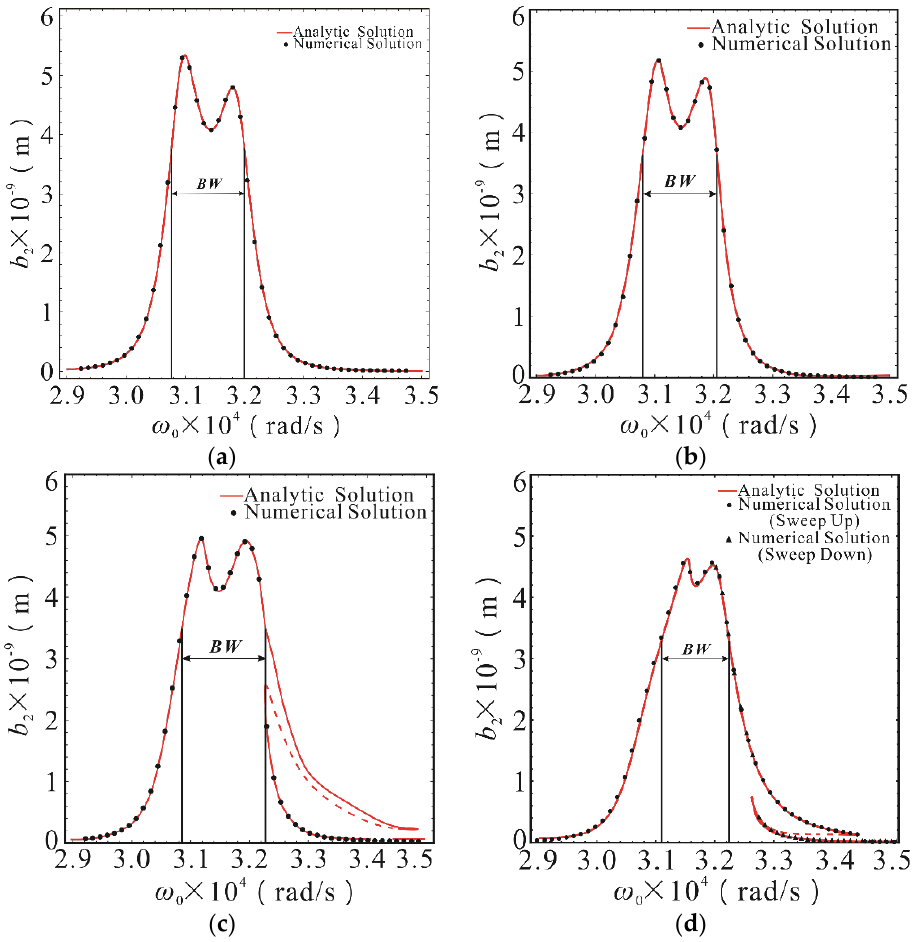
Figure 6. The amplitude-frequency response curves of second-order sense mode with different stiffness nonlinear coefficients in the case of σ 2 = 5.91 × 10 7 . ( a ) The case of K 1 = K 2 = 0; ( b ) The case of K 1 = K 2 = 10 11 N/m 3 ; ( c ) The case of K 1 = K 2 = 10 11.5 N/m 3 ; ( d ) The case of K 1 = K 2 = 10 12 N/m 3 . The point was calculated using the Runge-Kutta method. The line was calculated using the MMS. The solid lines represent the stable solution. The dashed lines represent the unstable solution. The BW area represents the 3dB bandwidth of the response.